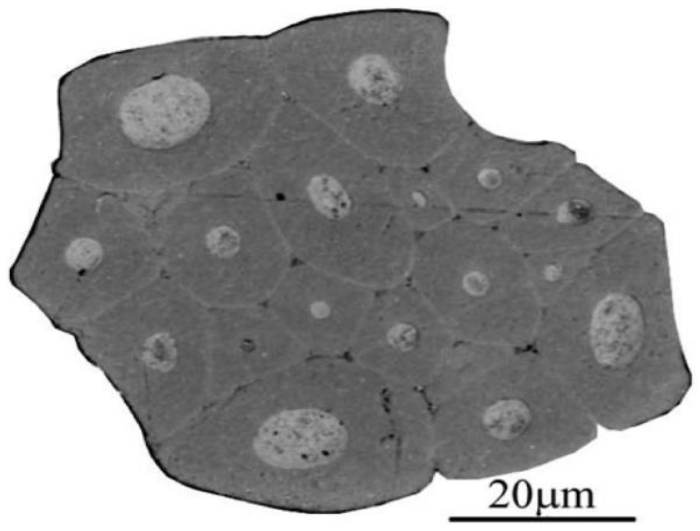
Figure 2. Laser microscope image of the CSA of hemp fibre [50] (reprinted with permission from Taylor & Francis, Licence Number: 501796223). Table 3. Cross-sectional area variations of different types of natural fibres